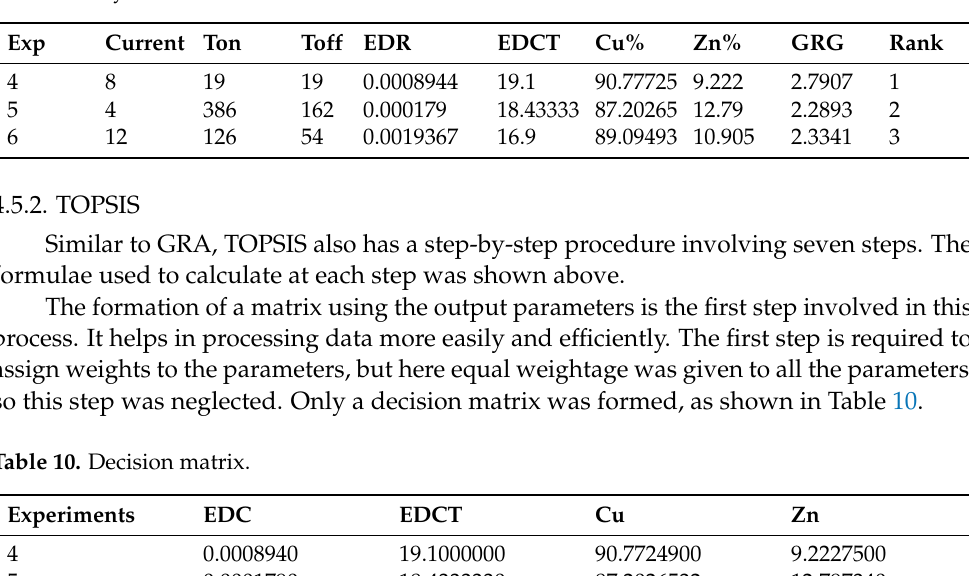
Table 9. Grey Relational Grade Generation.